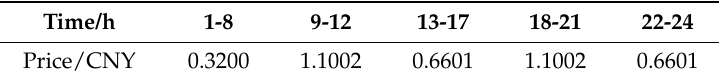
Table 2. The time-of-use electricity price.